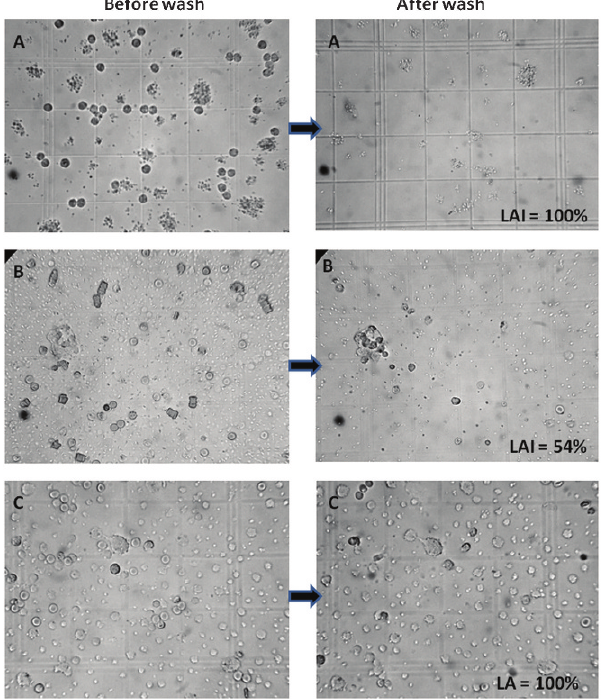
Figure 4 - Leukocyte adherence inhibition tests from two patients in group C before and after washing. Patient A exhibited leukocyte adherence inhibition (LAI)=100%. Patient B exhibited leukocyte adherence inhibition (LAI) = 54%. C = Control (without antigen) with leukocyte adherence